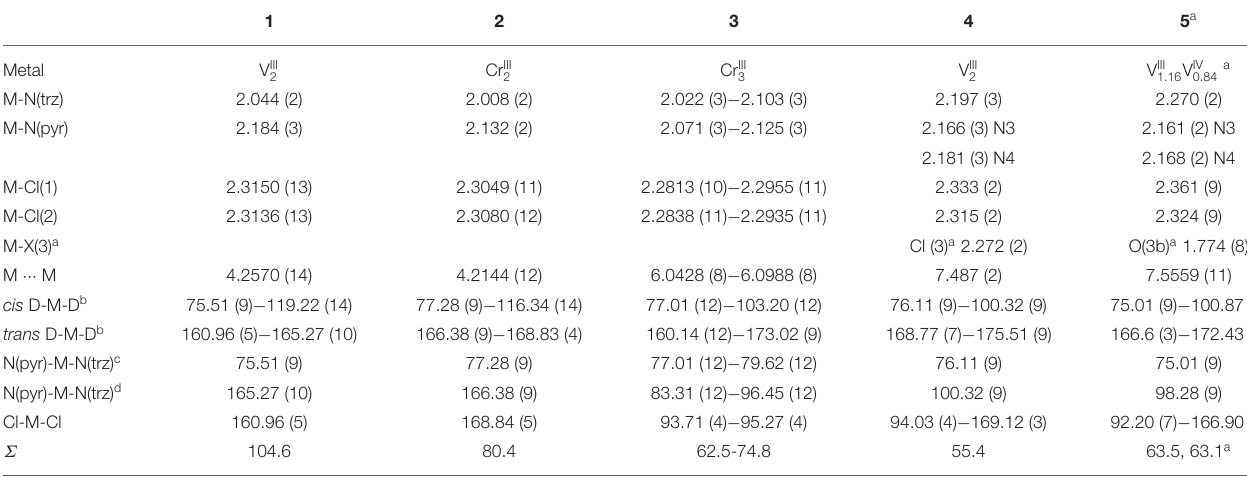
TABLE 1 | Selected bond distances (Å) and angles ( ◦ ) for compounds